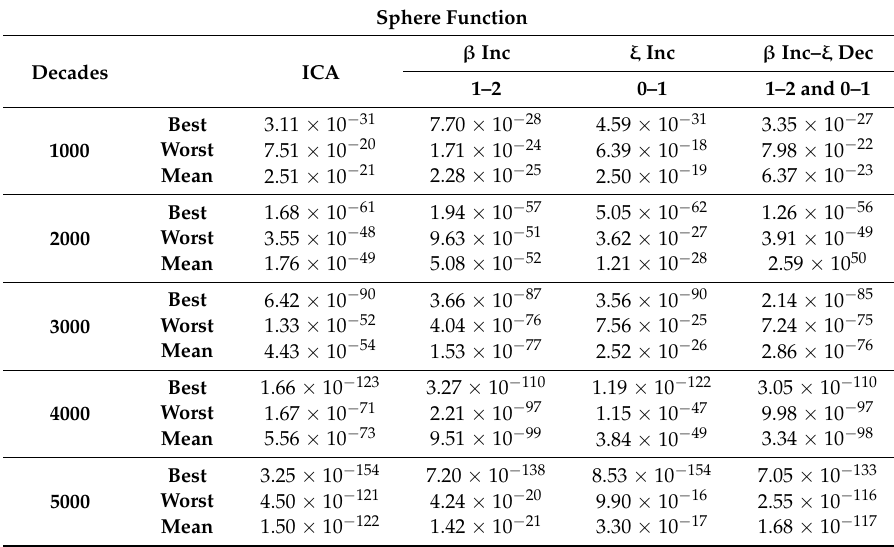
Table 1. Sphere function.